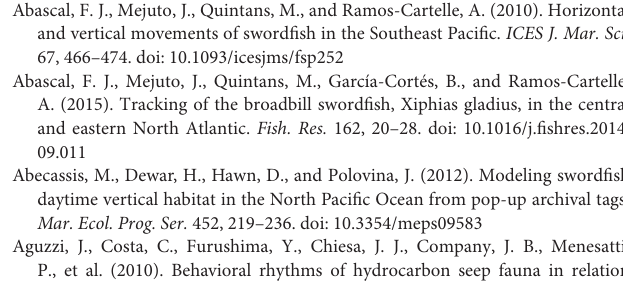
Supplementary Figure 4 | Kernel density estimates of space-use of tracked blue sharks for the surface-oriented behaviour. The red dashed line represents the 90th percentile for depth-oriented nDVM shown to exemplify the mismatch in hotspot location of the different